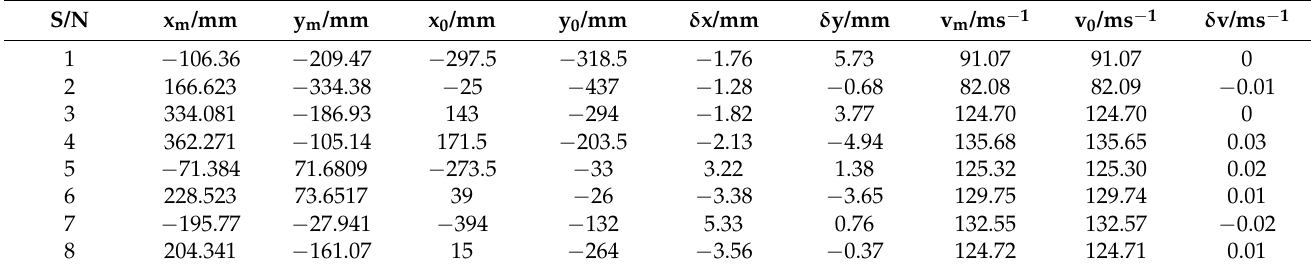
Table 2. Statistics for test data corresponding to Table